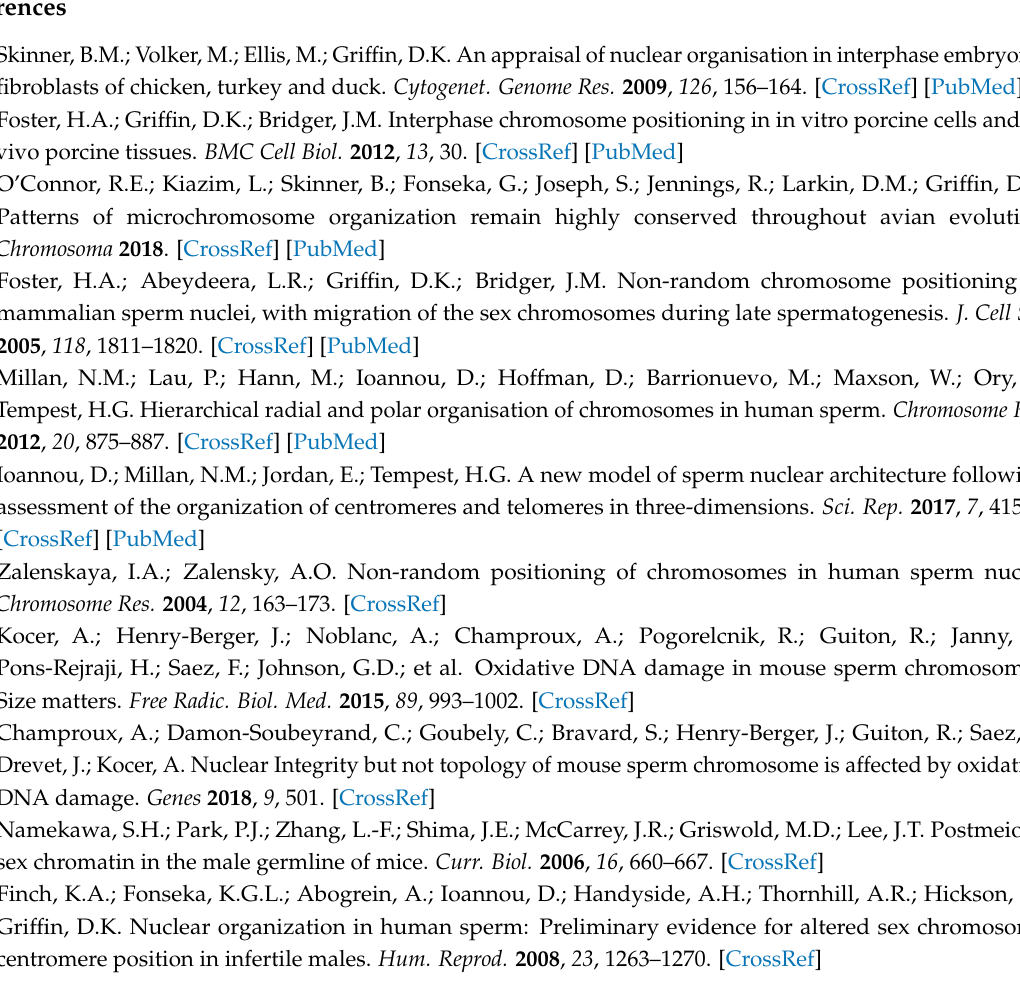
Figure S1: Chromosomes X and 19 co-hybridization; Figure S2: Comparison of MS-SSIM * scores using different warping templates; Figure S3: Examples of swelled and unswelled nuclei; Table S1: Numbers of nuclei with FISH signals analysed in this study., Table S2: Complete MS-SSIM* comparisons between warped composite images, including the individual similarity components of contrast, luminance and